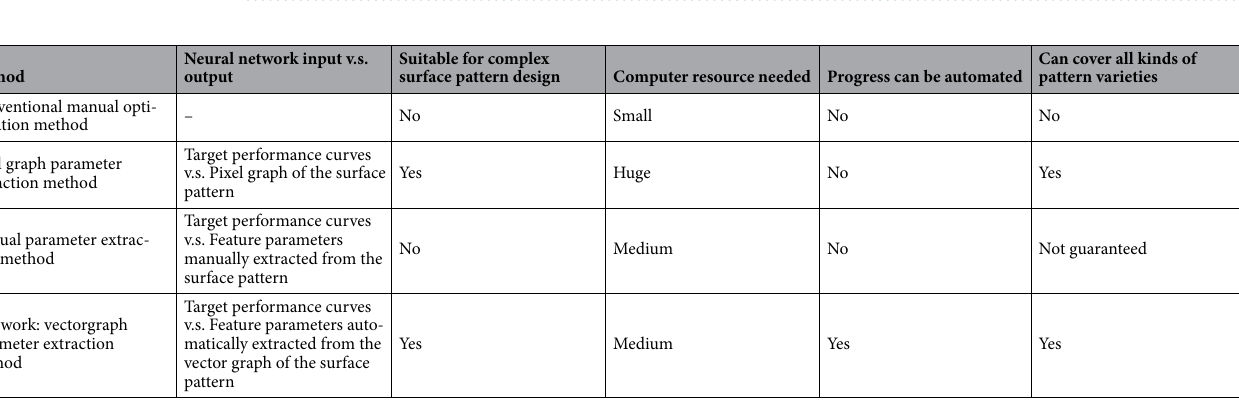
Figure 2. Flowchart of vectorgraph parameter extraction method design process.